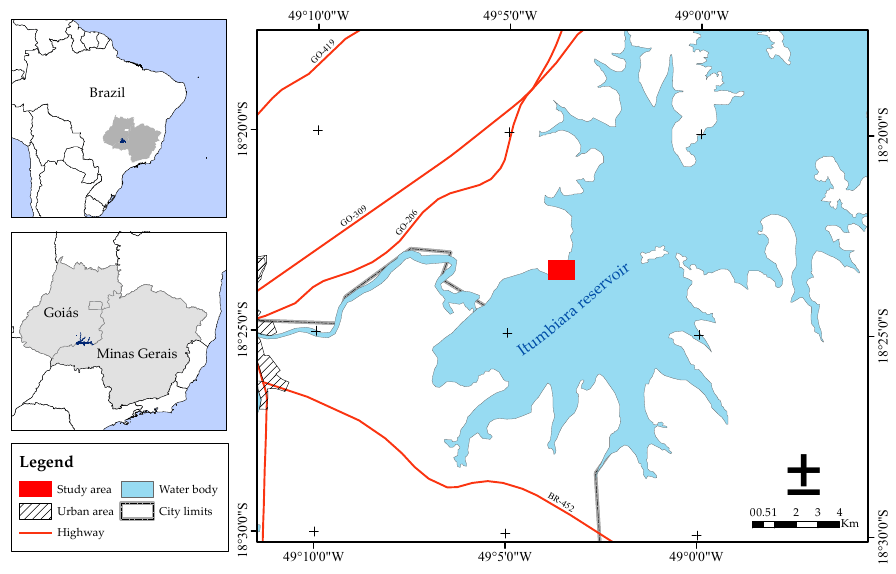
Figure 1. Location map of the study area.